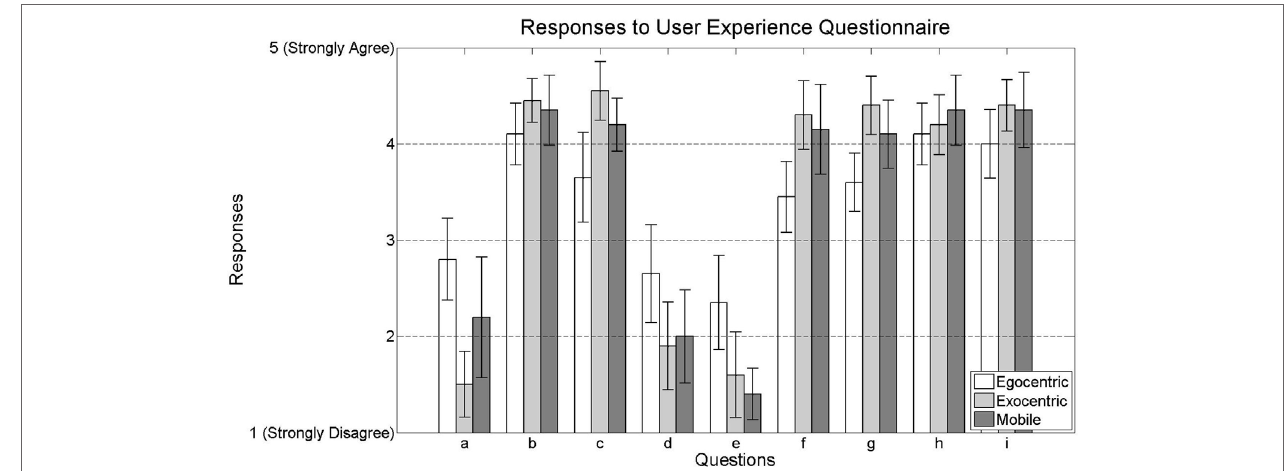
FigUre 12 | Participants’ levels of agreement with each statement in the user experience questionnaire